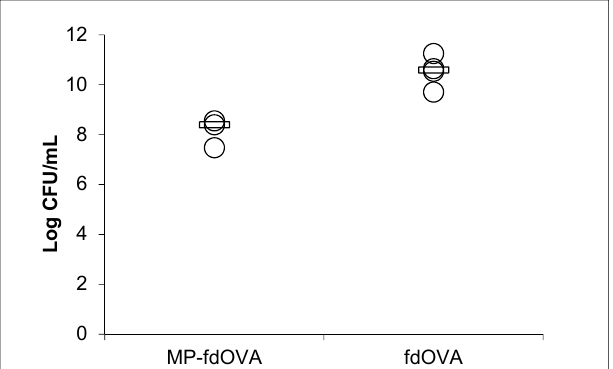
Figure 9. E ff ect of the encapsulation process on the biological activity of the bacteriophage. Infectivity of free filamentous bacteriophage fdOVA or fdOVA released from MPs (MP-fdOVA). The infectivity was expressed as the number of colony-forming units of TG1 E. coli bacterial cells infected with bacteriophage that were able to grow on Ampicillin plates. Each measurement was performed in triplicate, and the median of three di ff erent experiments is reported (black line). Di ff erences are not significant ( p > 0.05 by Student’s t